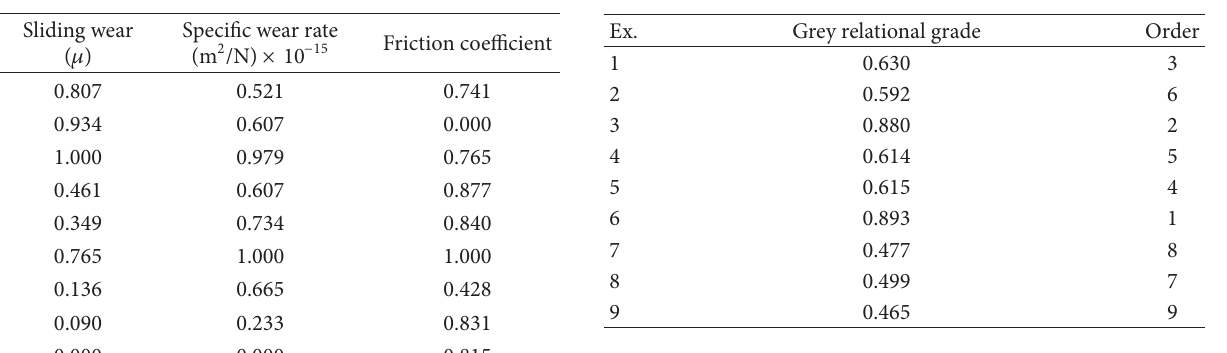
T 7: �n�uence of process parameters of Grey relational grade.